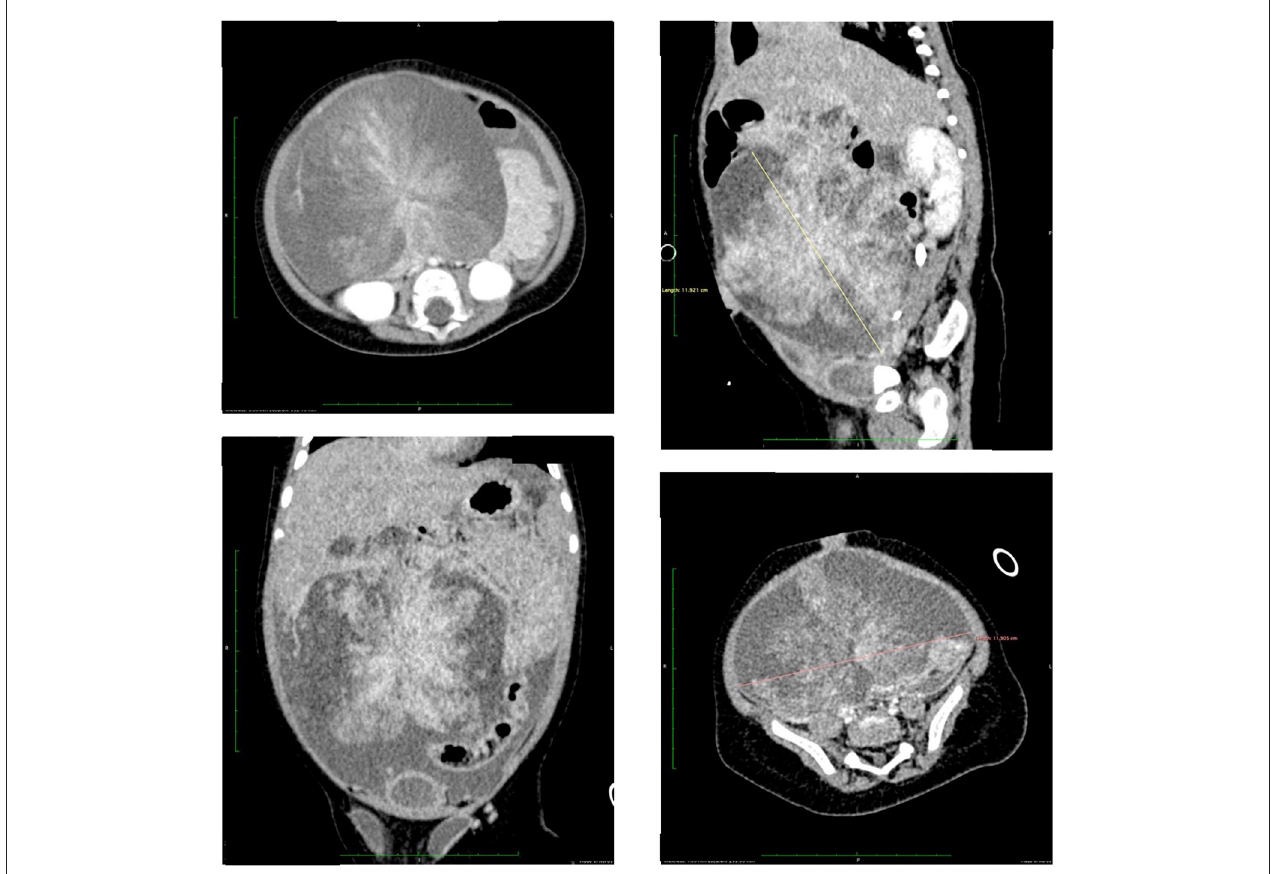
FIGURE 3 | Pre-operative CT scan: a solid-cystic mass (113 × 98 × 103mm) in the right abdominal